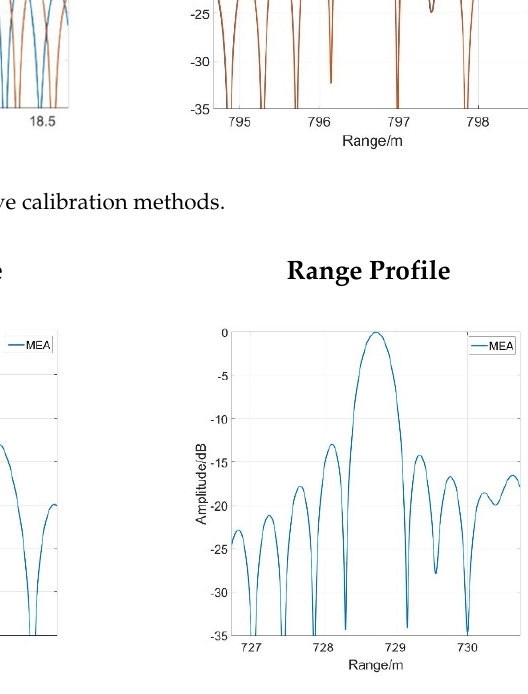
Figure 13. Target profile of self-calibration method.